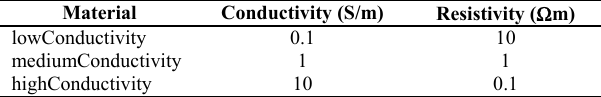
Tab.1: Electrical properties of the materials used in FEM